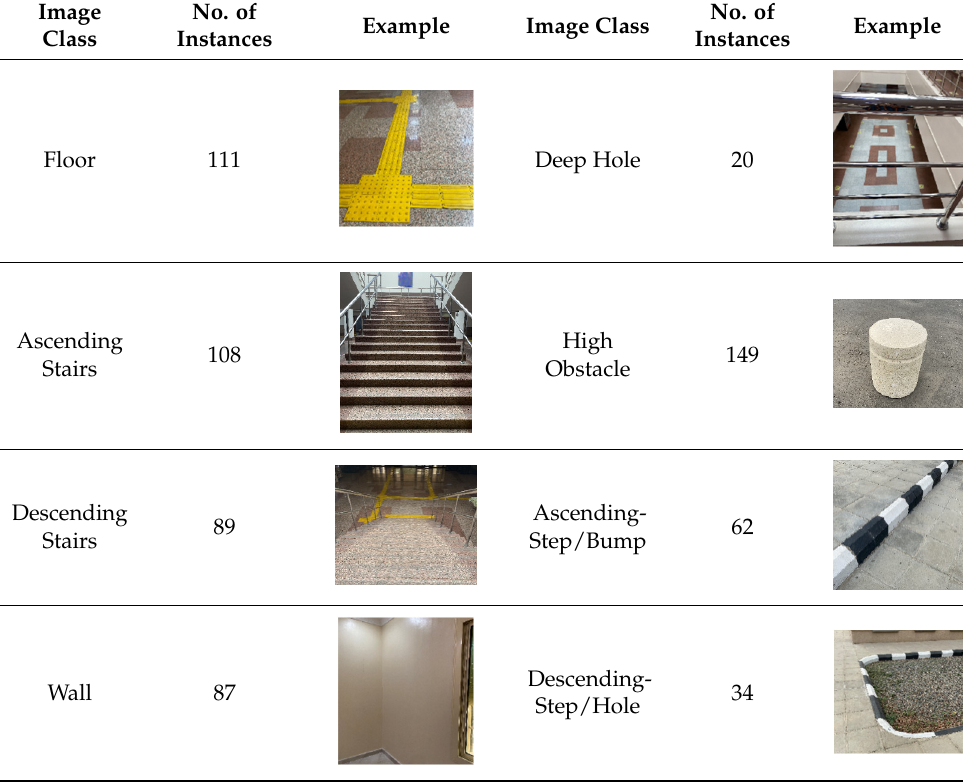
Table 3. Obstacle Dataset.